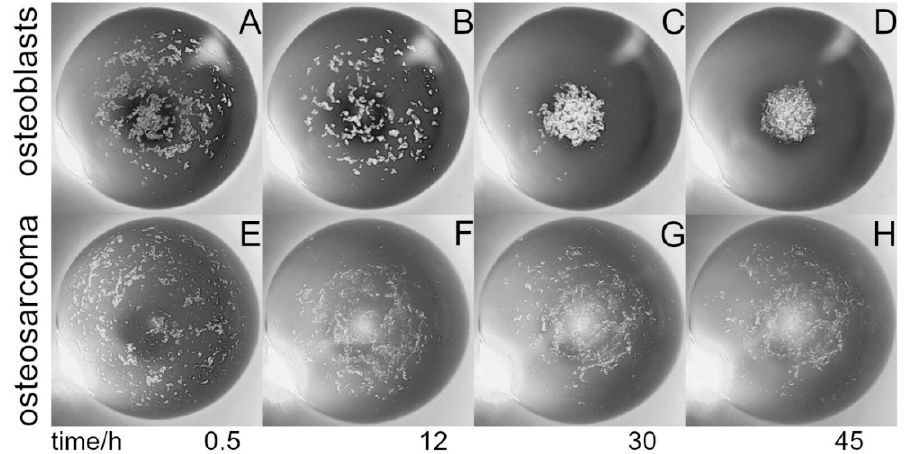
Figure 3. Hanging drop cell aggregation: Shown are time-series photos visualizing cell aggregation within a hanging drop contained 5000 cells in a 20 µL medium, viewed from underneath. The sus- pension was dispensed on the Teflon chip and incubated within the humidified chamber for indicted times. The images were acquired using the delta kinematic stage equipped with a commercially avail- able low-cost video microscope (see Figure 2). The cell aggregation shown here was performed using human fetal osteoblasts, hFOB1.19 ( A – D ), and human osteosarcoma cells, Saos-2 ( E – H ). The field of view is 3